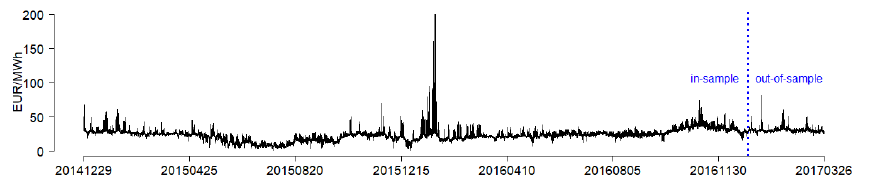
Figure 8. The system price in the Nord Pool day-ahead market in the period 29 December 2014– 26 March